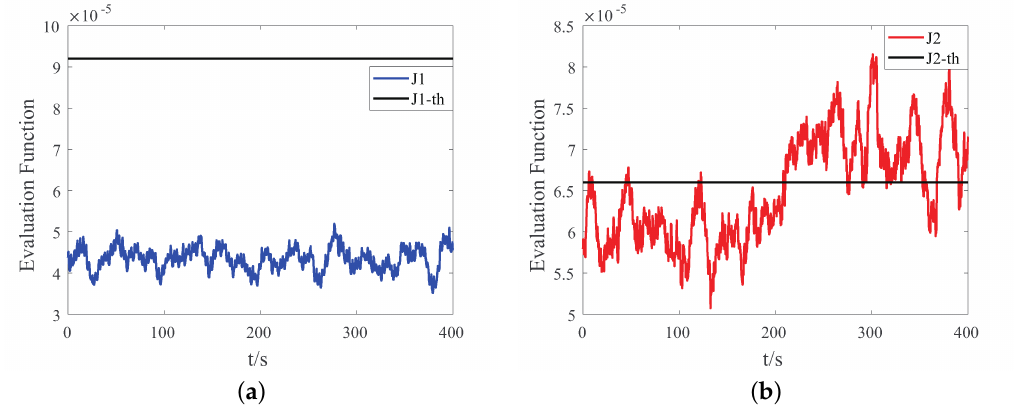
Figure 9. Simulation results of the proposed method with fault modes i = 3 occurring at 200 s: ( a ) the evaluation function J [ 1 ] with auxiliary signals. ( b ) the evaluation function J [ 2 ] with auxiliary